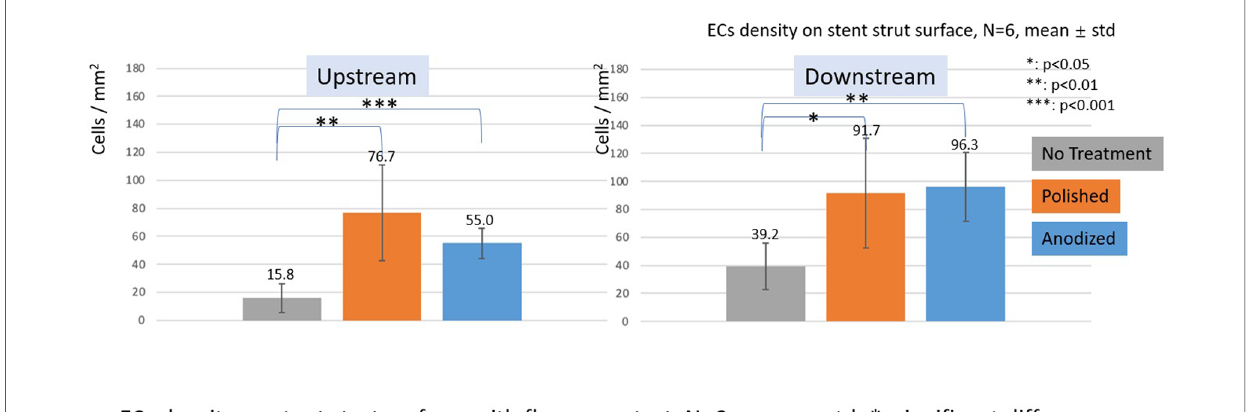
FIGURE 8 ECs density on stent strut surfaces, with fl ow 24-h, one strut, N =6, mean±std; T -test was performed to compare the signi fi cant difference (* p <0.05; ** p <0.01; *** p <0.001).